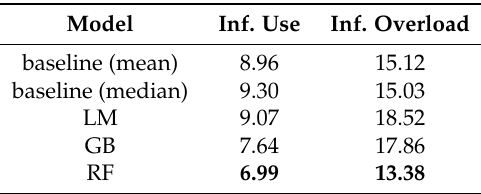
Table 1. MSE Scores for Models and